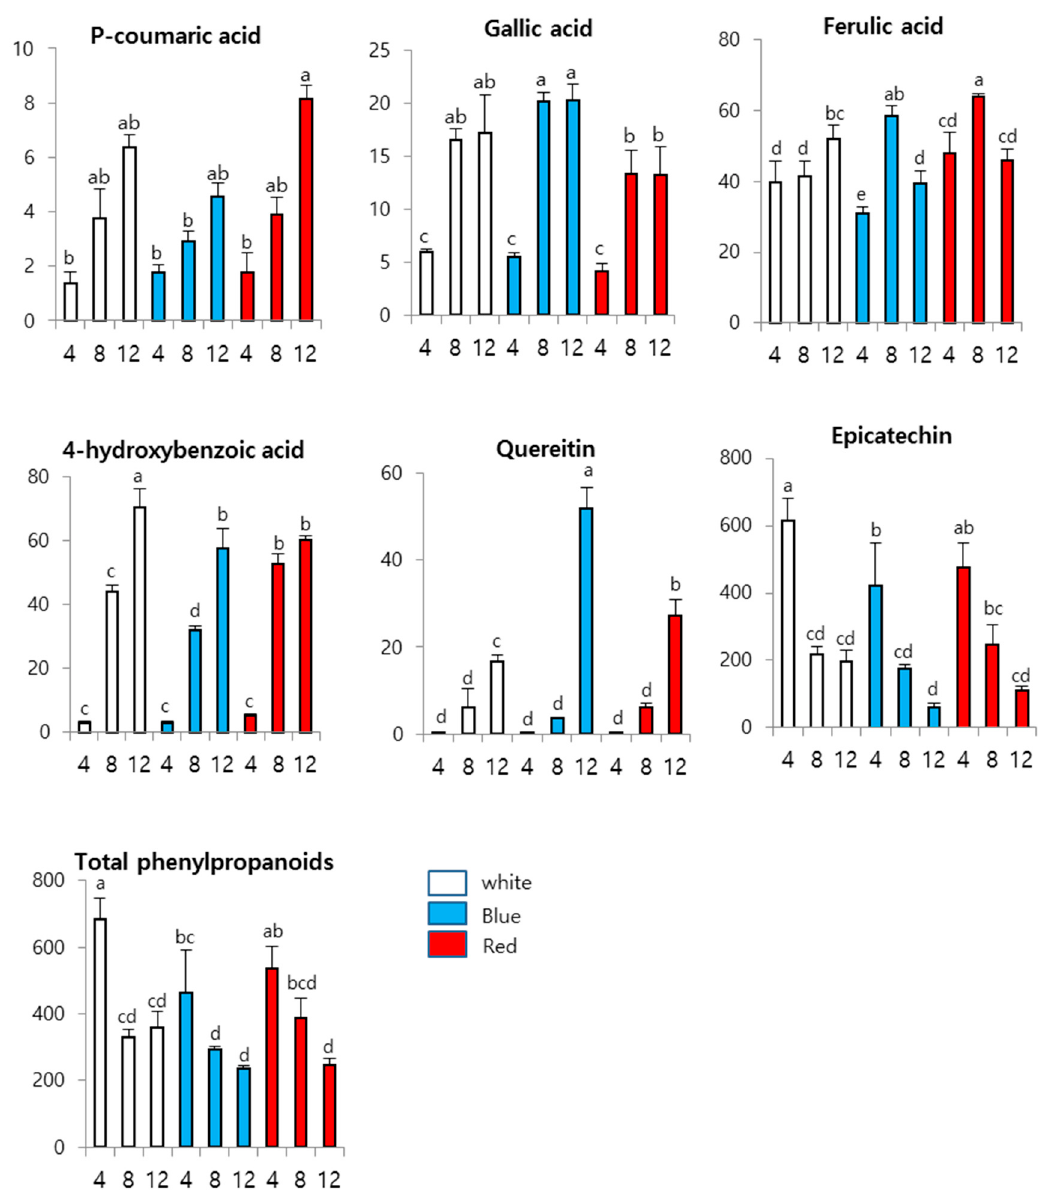
Figure 4. Phenylpropanoid content (µg/g dry weight) in wheat sprouts irradiated with white, blue, and red LED lights. Samples were harvested after 4, 8, and 12 days of growth under illumination and used for HPLC analysis. The means and standard deviations were obtained from three independent experiments. Letters a–e indicate significant differences ( p < 0.05).